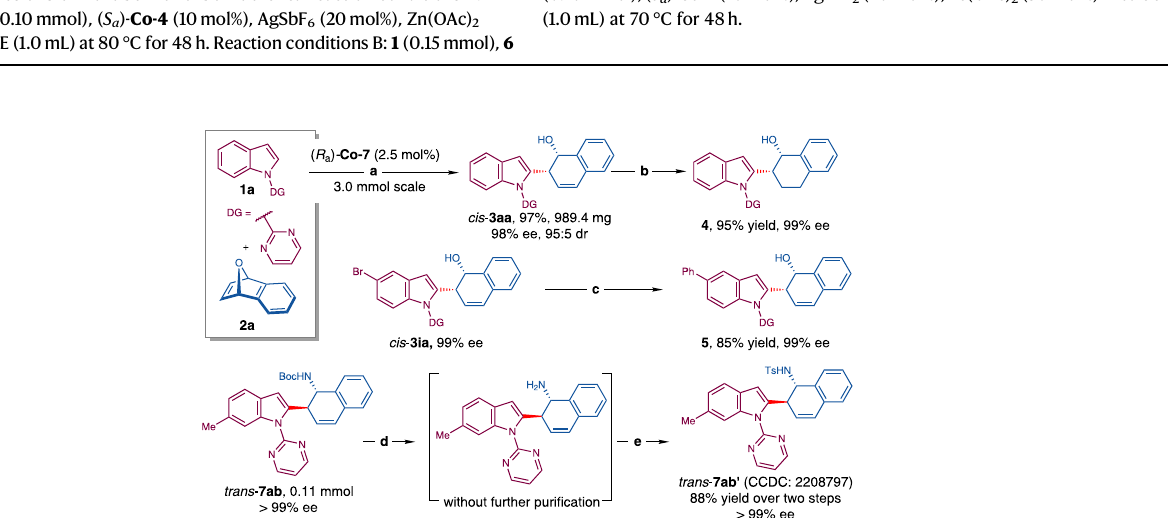
(0.10mmol),( S a )- Co-4 (10mol%),AgNTf 2 (20mol%),Fe(OAc) 2 (50mol%)intoluene (1.0mL) at 70°C for